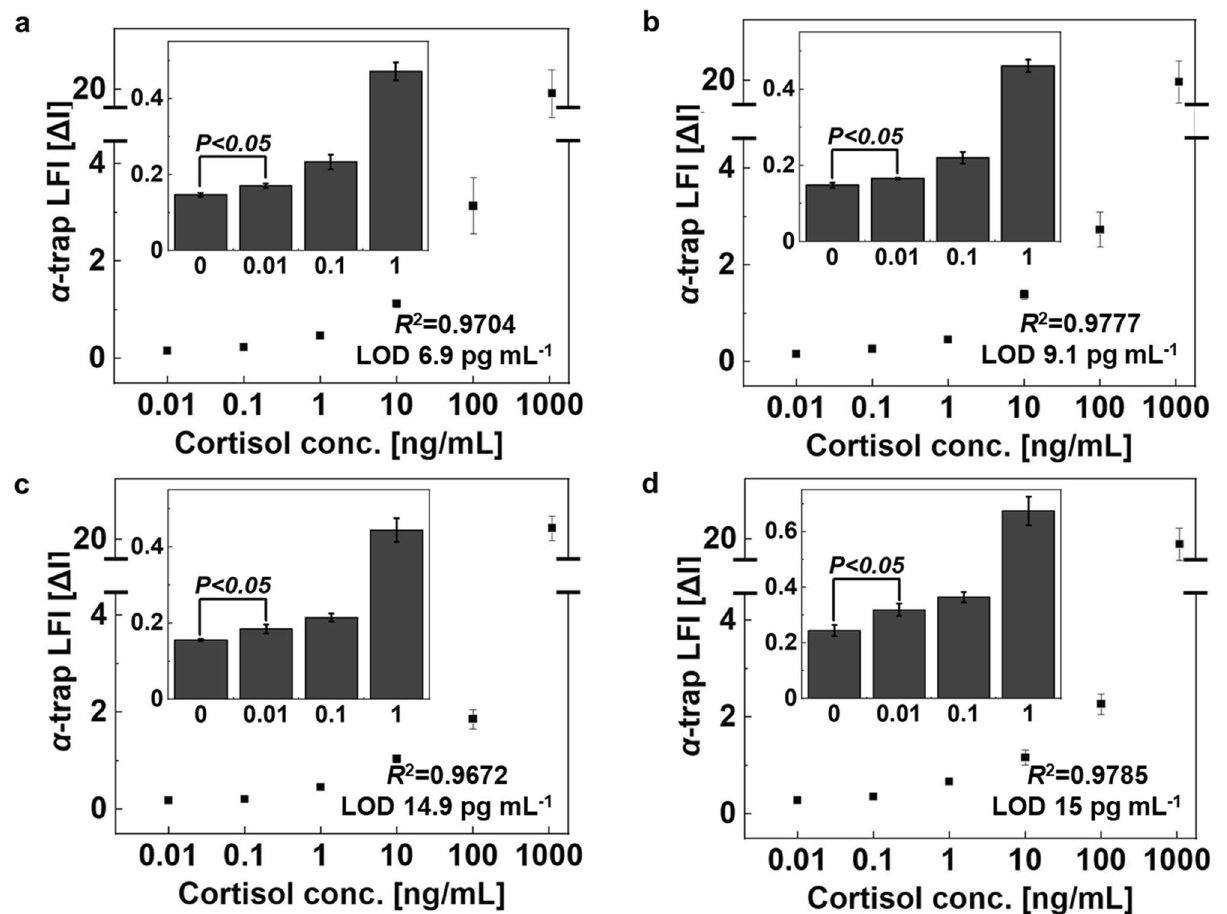
Figure 5. Sensitivity of α -trapLFI sensor for cortisol determination in human bodily fluids. Cortisol standard in ( a ) buffer, ( b ) saliva, ( c ) serum, and ( d ) urine. All images were obtained using a ChemiDoc XPS + imaging system (Bio-Rad), and the band intensities were measured using Image Lab software (version 6.1, https:// www. bio- rad. com/ en- uk/ produ ct/ image- lab- softw are? source_ wt= image labso ftware_ surl& ID= KRE6P 5E8Z). Error bars indicate the standard deviation from three independent